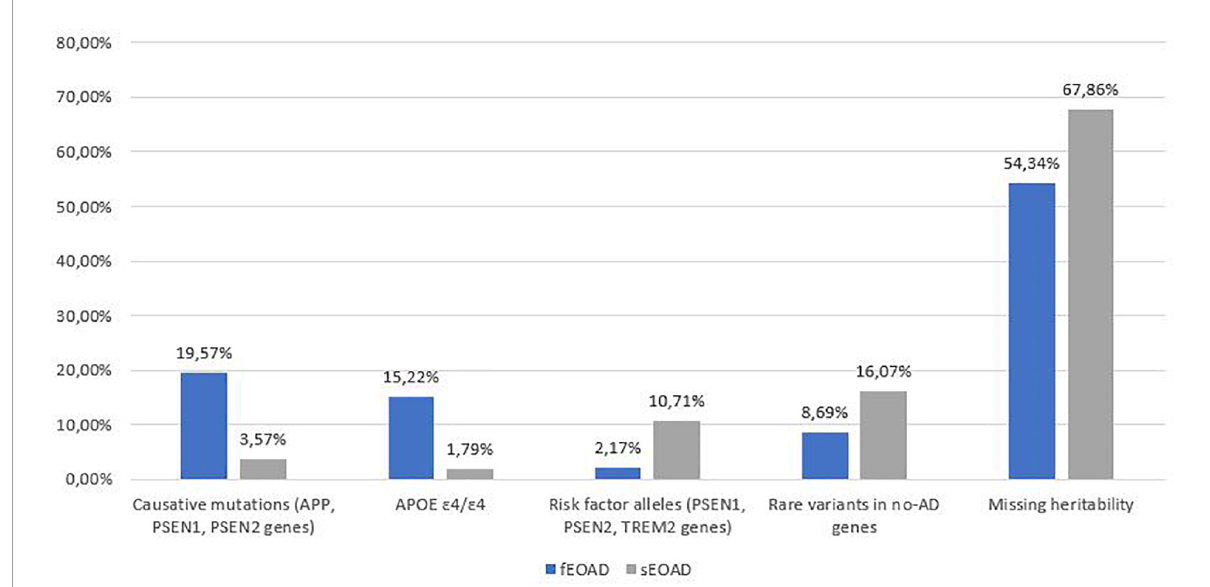
FIGURE1 Summary of genetic variants identified in the 102 AD patients, divided into familial (fEOAD) and sporadic patients (sEOAD). Causative mutations included diagnostic and strong contributor alleles in APP , PSEN1, and PSEN2 genes, moderate risk alleles included variant not strictly pathogenic in APP , PSEN1 , PSEN2, and TREM2 genes, rare variants in no-AD genes included pathogenic/likely pathogenic/VUS (uncertain significant variants or with major evidence of pathogenicity in ClinVar and/or HGMD) variants in genes causative for other type of dementia ( Supplementary Table 1